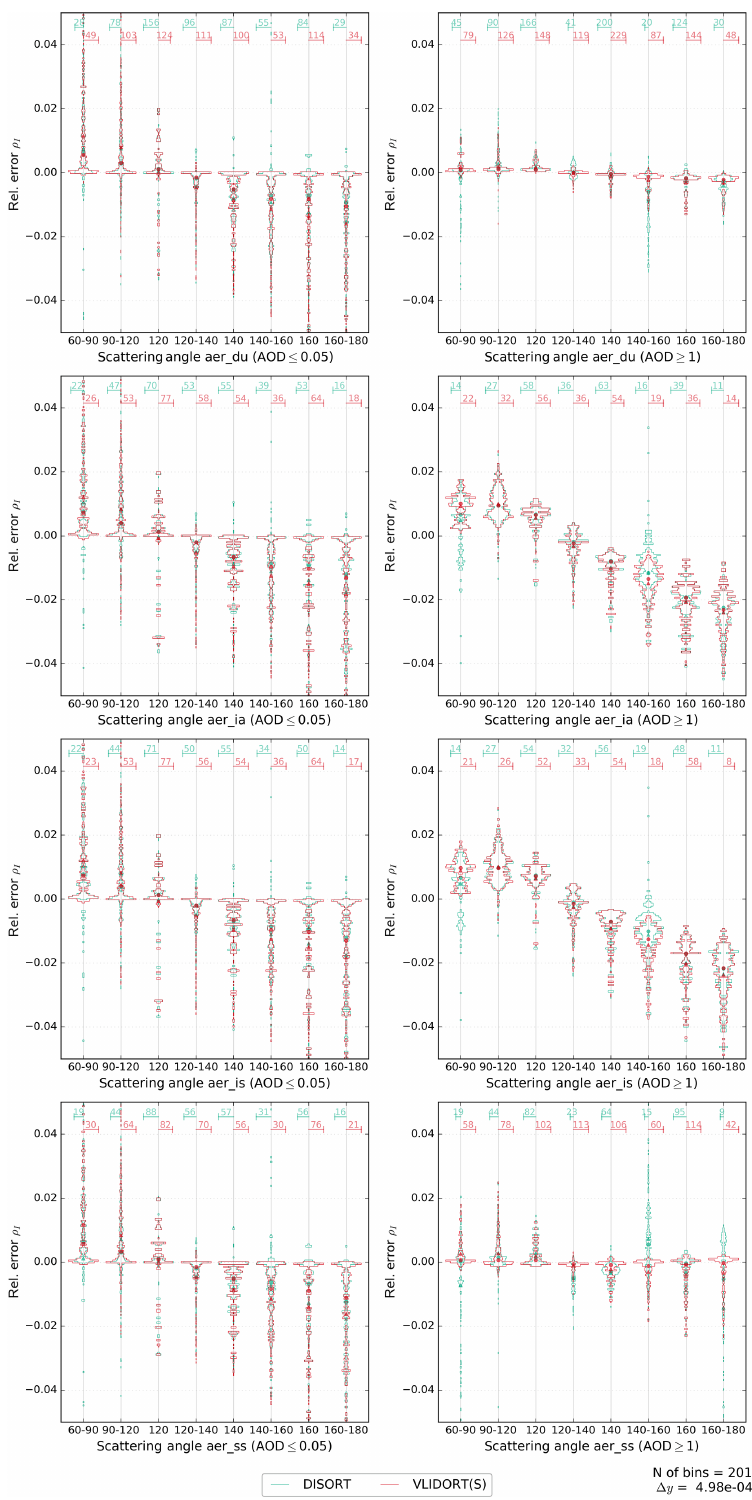
Figure A2. Histograms for the relative error of the VLIDORT (scalar) and DISORT models. Similar to Fig. 4 but only for AOD ≤ 0 . 05 on the left column and AOD ≥ 1 in the right column (AOD at 550nm). Relative error histograms are presented as a function of the scattering angle. The scattering angle has been binned at intervals with a similar quantity of data. The four aerosol types considered in this work are shown in different